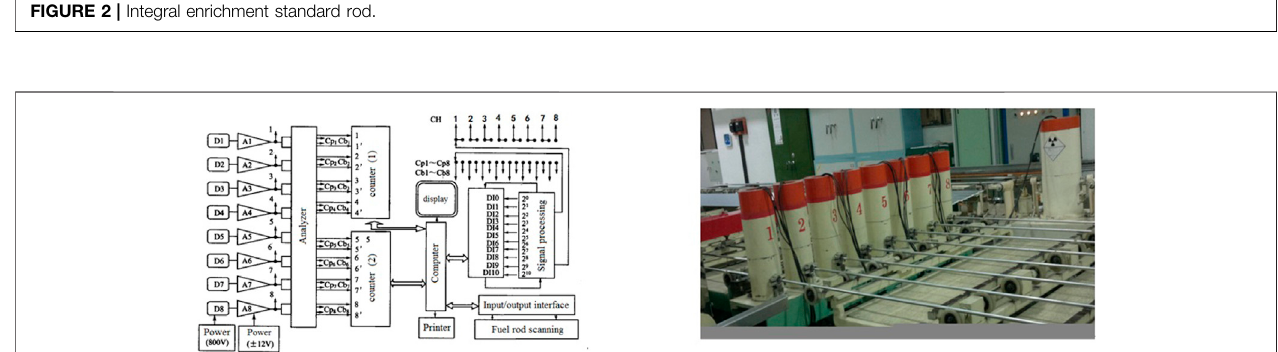
FIGURE 3 | single probe inspection equipment.